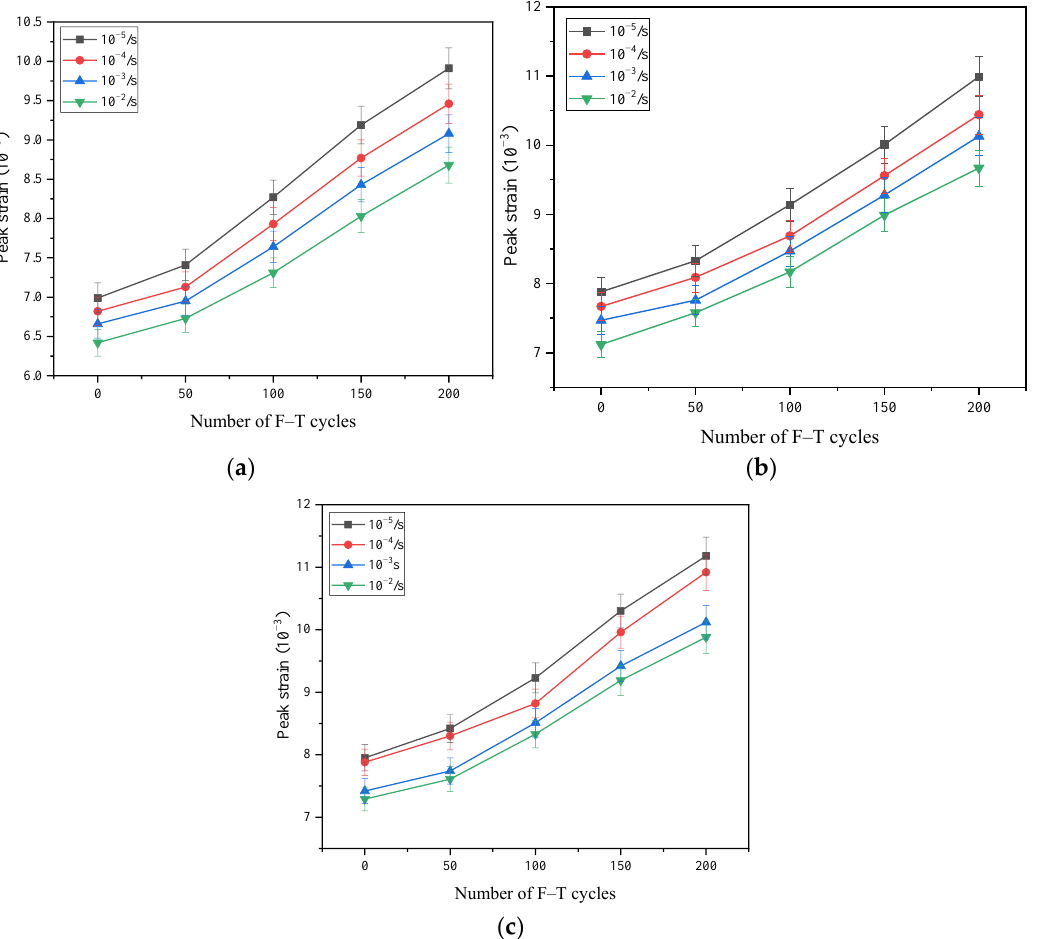
Figure 8. Peak strain of concrete specimens with 5 MPa confining pressure under different number of F – T cycles. ( a ) SF0, ( b ) SF10 and ( c ) SF20. The axial peak strain of all concrete after 100 F – T cycles is shown in Figure 9. All mixtures share an obvious feature in that increasing the strain rate consistently reduces the axial peak strain. For SF0, when the confining pressure is 0 MPa, the axial peak strain (Figure 9a) under the strain rate of 10 −4 /s, 10 −3 /s and 10 −2 /s are decreased by 4.4%, 8.0% and 10.6%, respectively, compared with that under the strain rate of 10 −5 /s. As a result, with the same number of F – T cycles, the axial peak strain of concrete specimens without steel fiber falls as the strain rate increases. Figure 9b, c reveal that the concrete with 1% and 2% steel fiber shows a similar trend. Figure 9 displays the impact of confining pressure on the axial peak strain of all mixes.